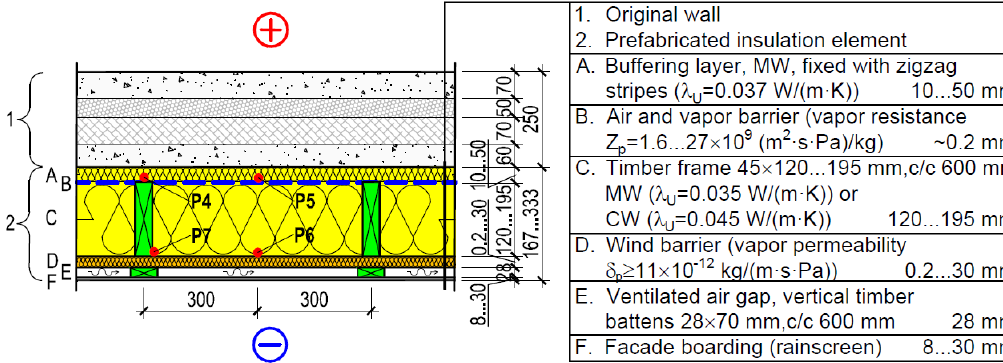
Figure 1. Horizontal cross-section of the original wall with installed prefabricated timber frame insulation element and analyzed critical points.